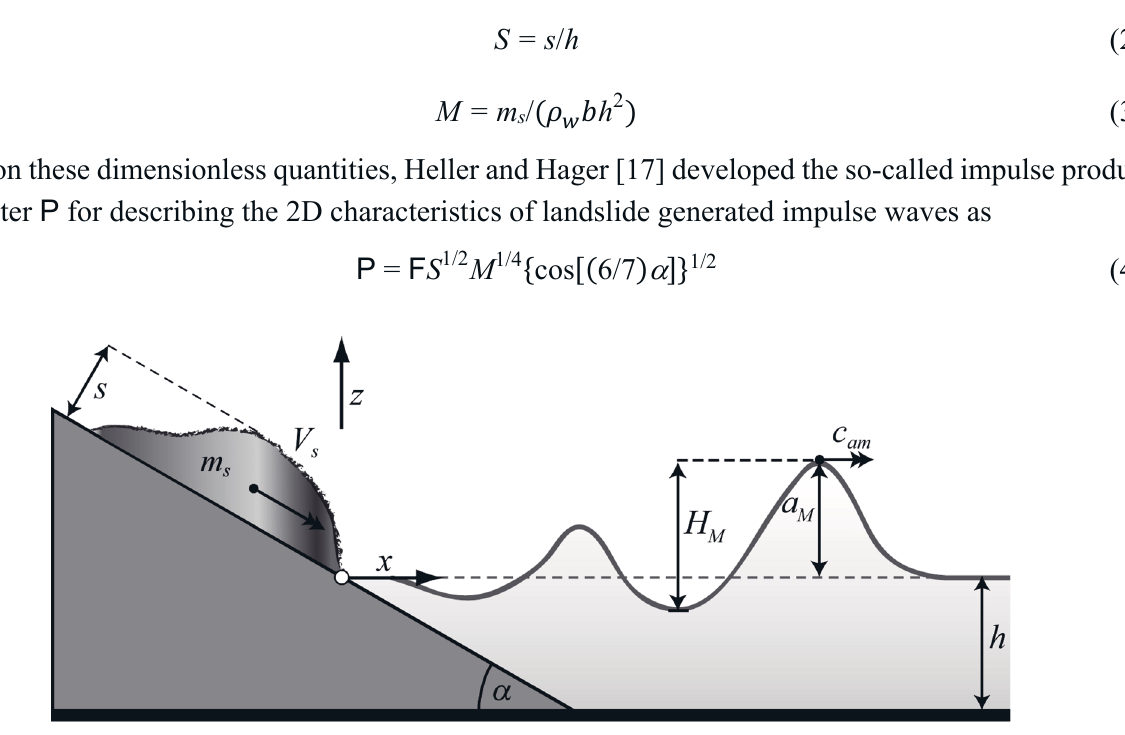
Figure 1. Relevant slide parameters and wave characteristics (adapted from Heller [4], with permission from